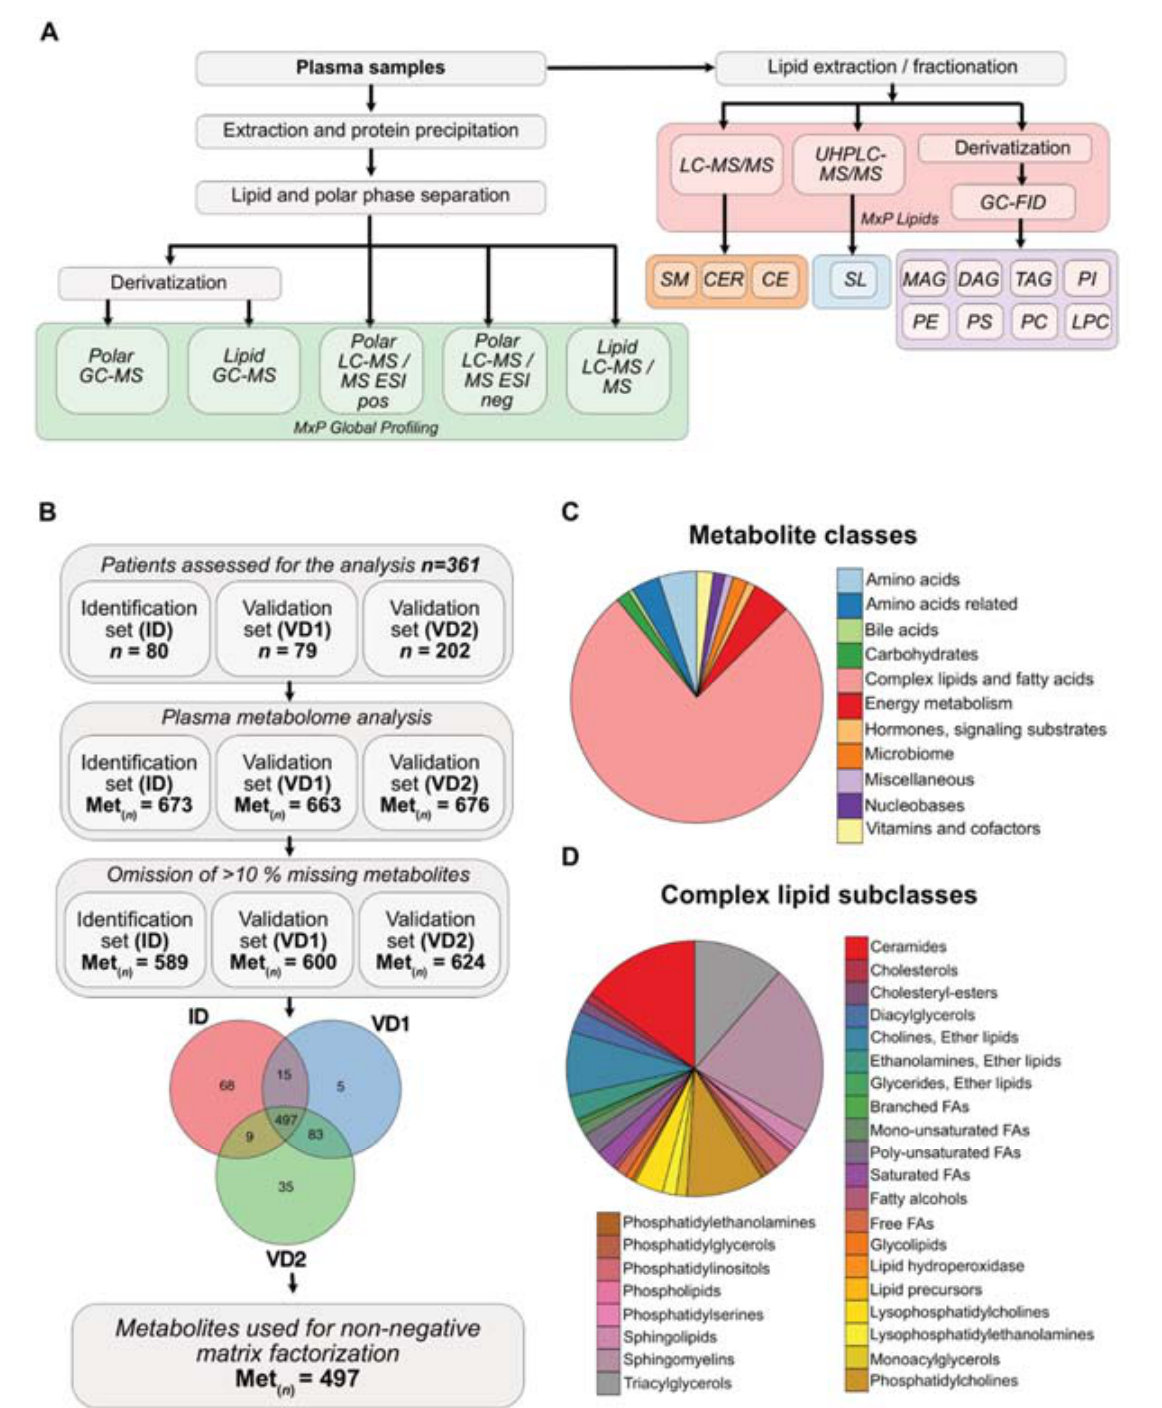
Figure 1. Plasma metabolome analysis of the PDAC disease cohort: ( A ) schematic representation of workflow of plasma metabolome analysis using MxP ® Global Profiling and MxP ® Lipids. GC: gas chrmoatography; MS: mass spectrospectry; ESI: electrospray ionization; UHPLC: ultra-high performance liquid chromatography; FID: flame ionization detector; SM: sphingomyelins; CER: ceramides; CE: cholesterylesters; SL: sphingilipids/sphingoids; MAG: monoacylglycerols; DAG: diacylglycerols; TAG: triacylglycerols; PI: phosphotidylinositols; PE: phosphatidylethanolamines; PS: phosphatidylserines; PC: phosphatidylcholines; LPC: lysophosphatidylcholines. ( B ) CONSORT diagram of patients recruited for the metabolic analysis and downstream metabolite selection. ( C ) Pie chart of distribution of detected metabolite classes. ( D ) Pie chart of distribution of detected complex lipid